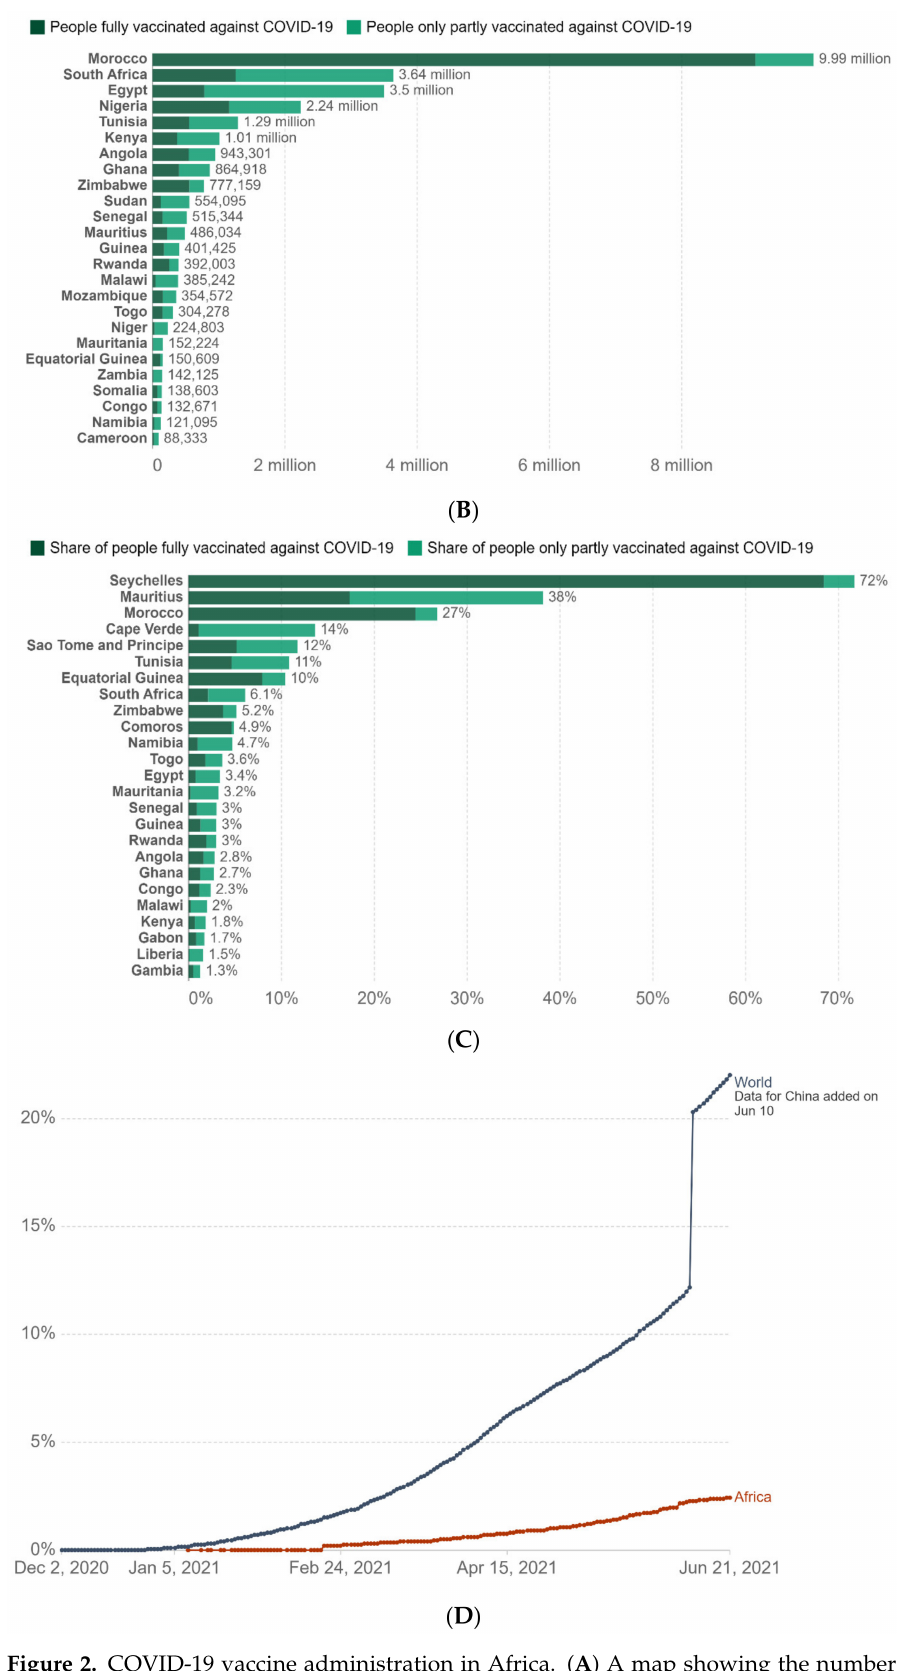
Figure 2. COVID-19 vaccine administration in Africa. ( A ) A map showing the number of doses administered in each country. Source: Africa CDC vaccine board [34] ( B ) The number of people